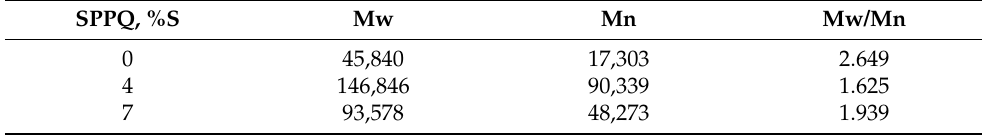
Figure 5. Molecular weight distribution in solutions of polymers PPQ and SPPQ in N-MP with the addition of triethylamine. The sulfur content in the samples is 0, 4, and 7%. Table 2. The molecular weight distribution of polymers